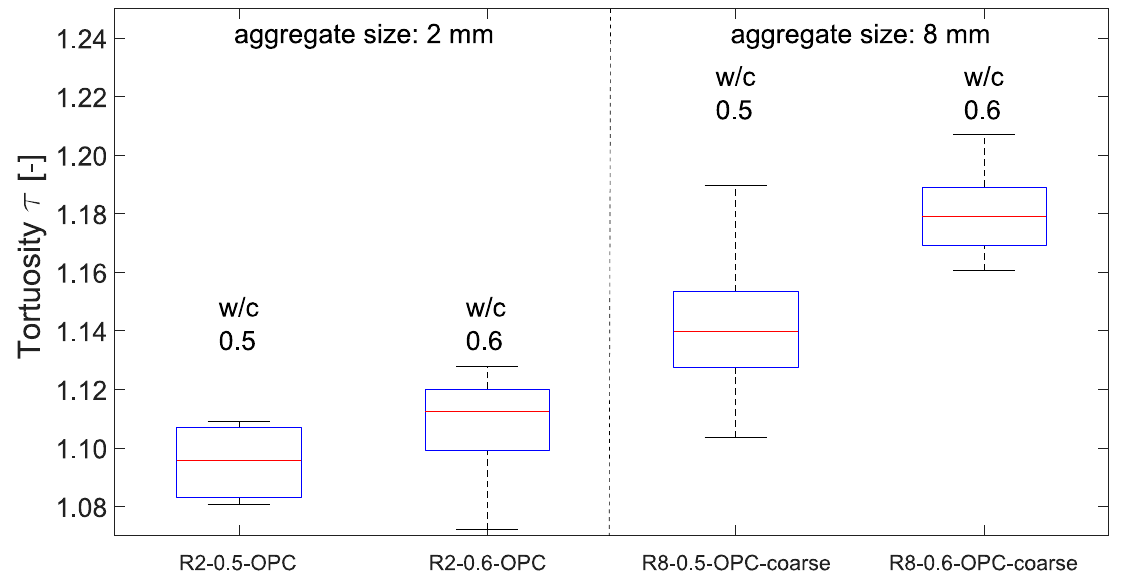
Figure 8. Effect of water-to-cement ratio on tortuosity for mixtures with 2 mm and 8 mm maximum aggregate size (bottom and top edge of a box indicate the 25th and 75th percentiles, the band inside a box is the median, whiskers extend to the minimum and maximum data point within the 1.5 times interquartile range).